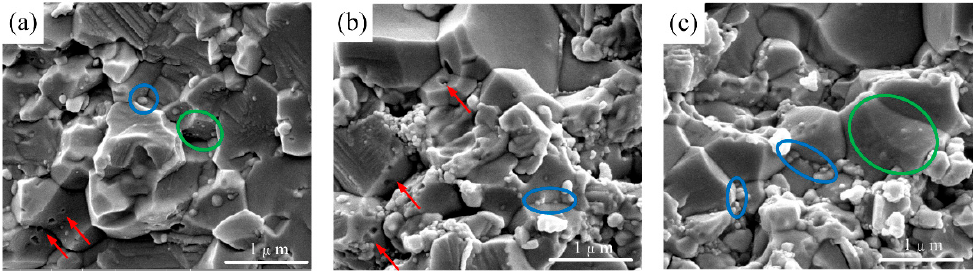
Figure 7. SEM morphology of ( a ) holes left by nano-TiC, ( b ) distribution of nano-TiC, and ( c ) distribution of nano-TiC. Green circles indicate nano-TiC in matrix grains, blue circles indicate nano-TiC in grain boundaries, and red arrows indicate holes left due to the peeling of nano-TiC.